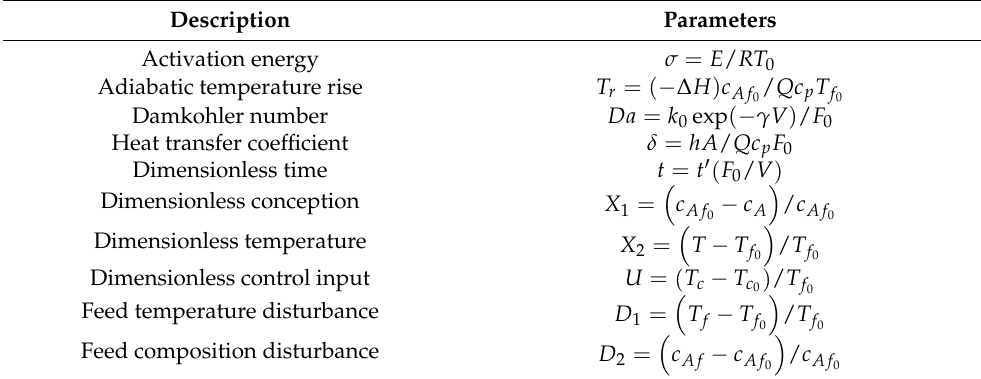
Table 1. Dimensionless parameters for the CSTR